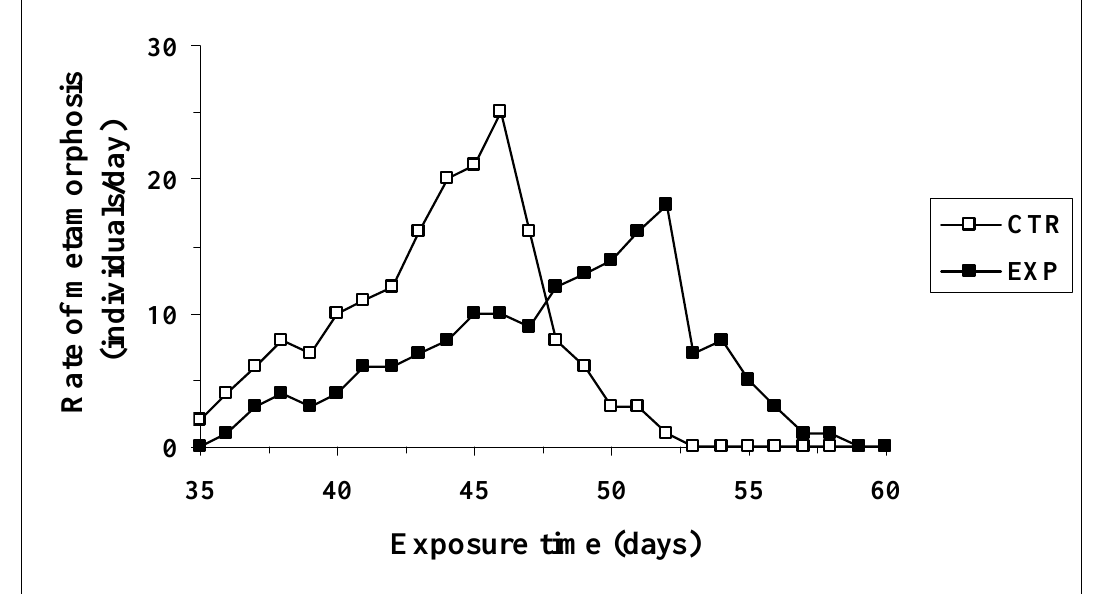
FIGURE 2 . MF dependence of daily tadpole metamorphosis rate. As daily rate of metamorphosis, the number of individuals undergoing metamorphosis in 24 h was taken. (o) Control population made by unirradiated individuals maintained outside the SLD; ( • ) experimental population made by individuals maintained inside the SLD. The points represent the mean of four sets of experiments.